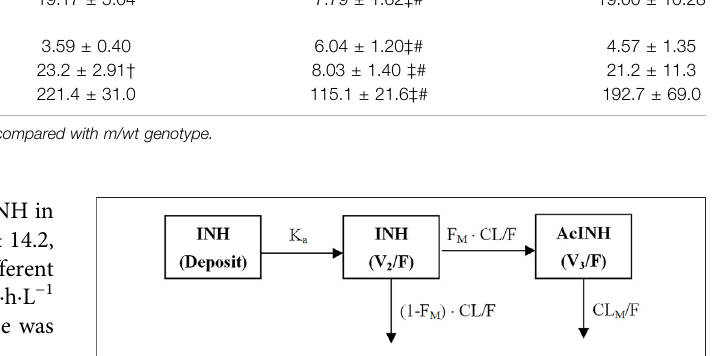
FIGURE 1 | Schematic fi gure of the integrated PPK model of isoniazid (INH) and acetylisoniazid (AcINH). K a : The absorption rate constant of INH. F: The oral bioavailability of INH. CL/F: clearance of INH. F M : The fraction of INH converted to AcINH. CL M /F: clearance of AcINH. V 2 and V 3 : volume of distribution of INH and